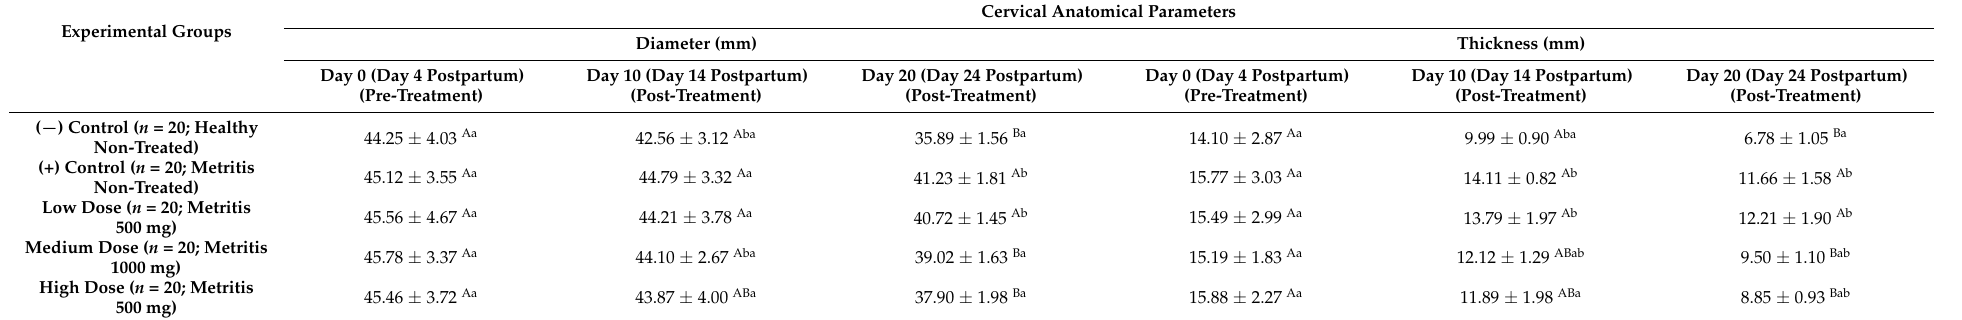
Anatomical measurements of cervical parameters on day 0 (before) and on days 10 and 20 after intrauterine infusion of Micronised Purified Flavonoid Fraction (MPFF; low, medium and high doses) in metritis-diagnosed dairy cows. Letters (A–B) in a row show statistical differences among timepoints within the same parameter ( p < 0.05). Different letters within a column (a–b) show differences among controls/treatment groups ( p <